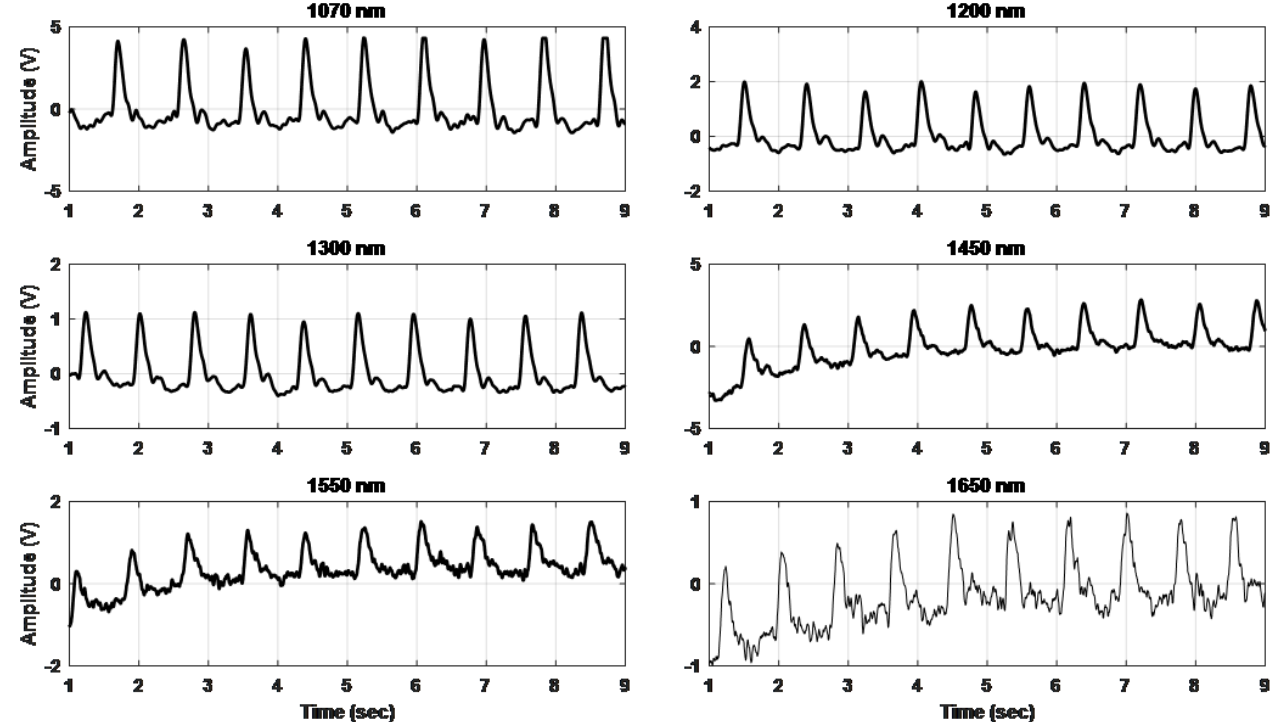
Fig. 9. Raw PPG signals for the 6 di®erent wavelengths.